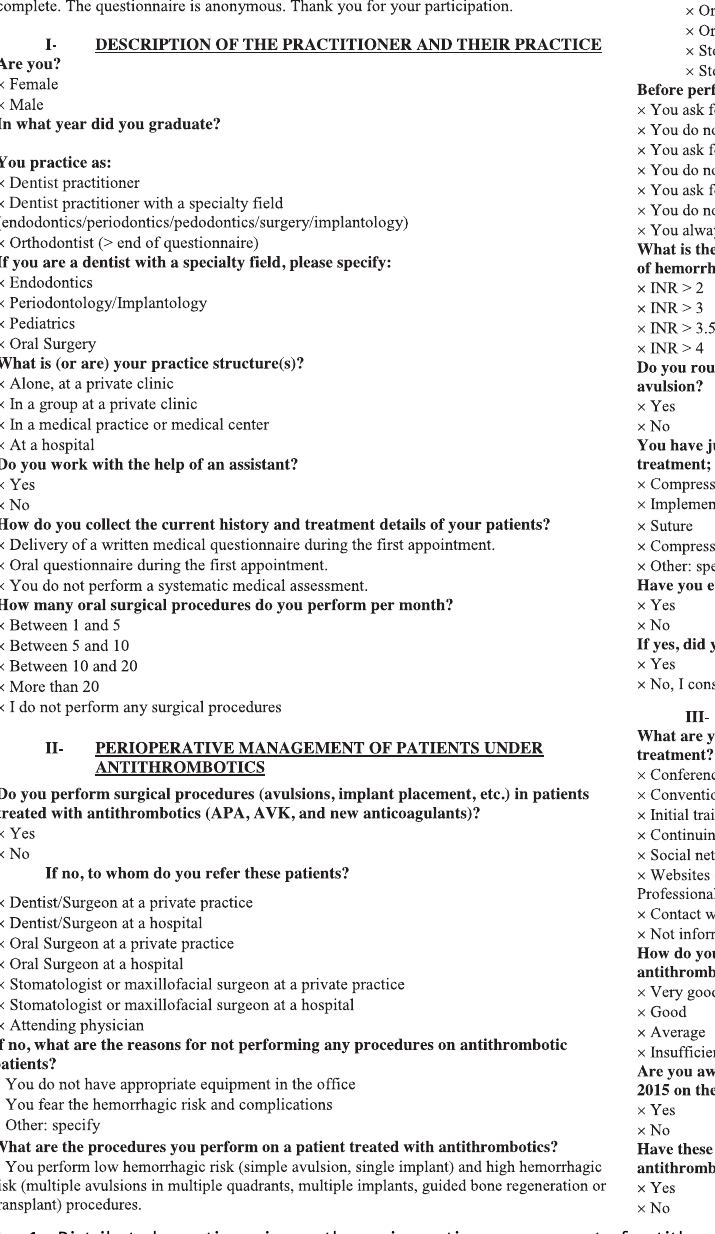
Fig. 1. Distributed questionnaire on the perioperative management of antithrombotic patients. The questionnaire comprised three sections with 23